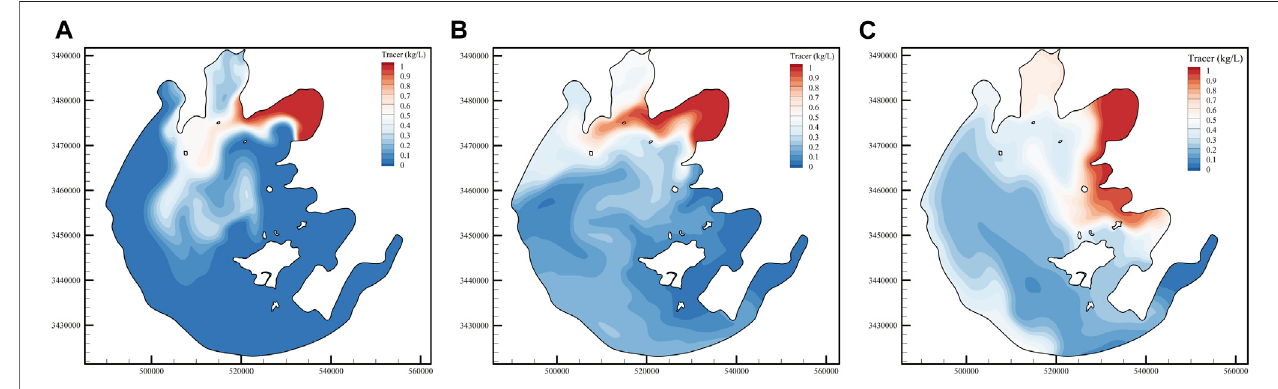
FIGURE 13 | Time series of tracer concentration images without the consideration of vegetation: (A) Jul, 31st, (B) Sept, 30th, and (C) Nov, 30th.